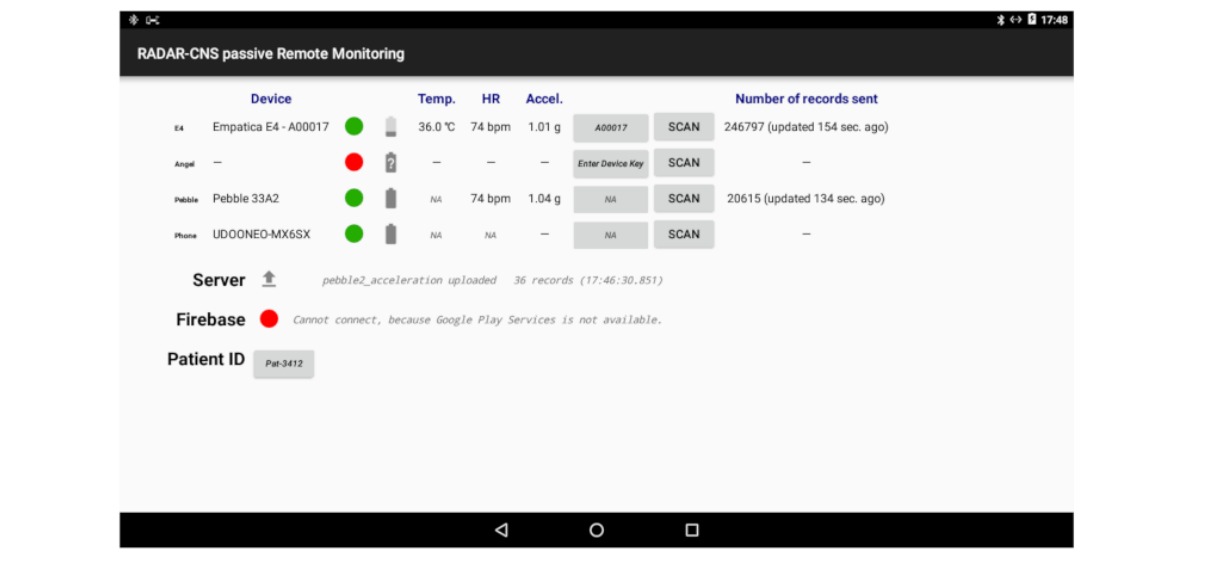
Figure 4. Passive Remote Monitoring app user interface. The Device column lists all the devices that are connected to the app and collect data. Device connection/disconnection is shown by green and red icons, respectively. The 3 columns next to “Device show the different values that are being measured on the connected devices. The last column shows the amount of data (or records) that have been